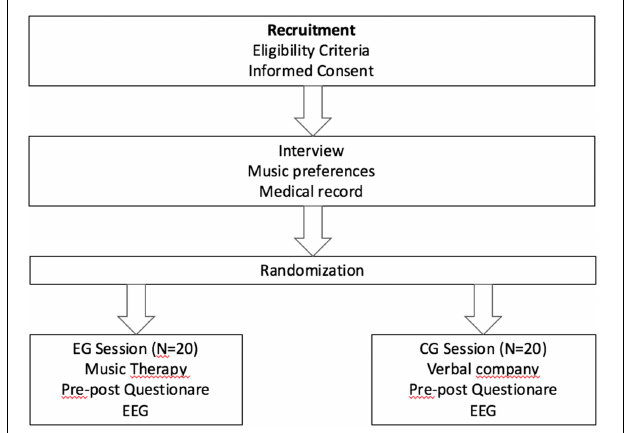
FIGURE 2 | Flow diagram of the study